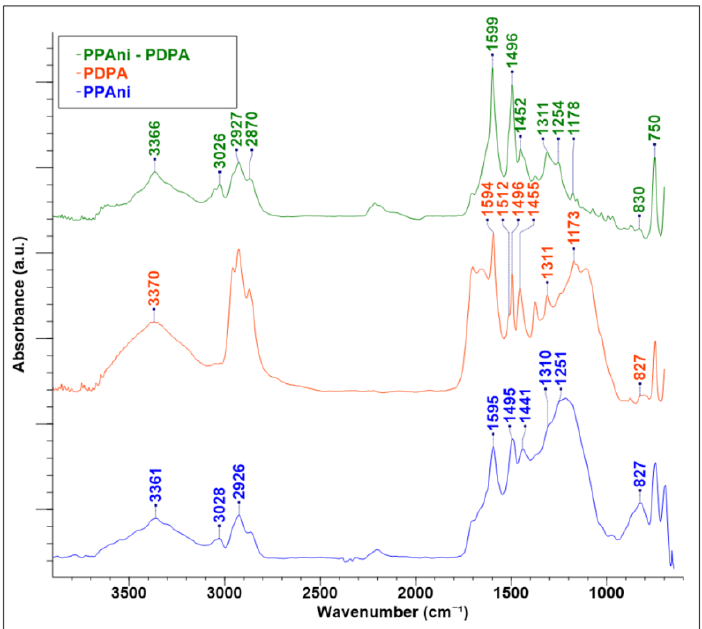
Figure 3. FT-IR spectra of plasma polymer thin films PPAni, PDPA, and PPAni-PDPA.